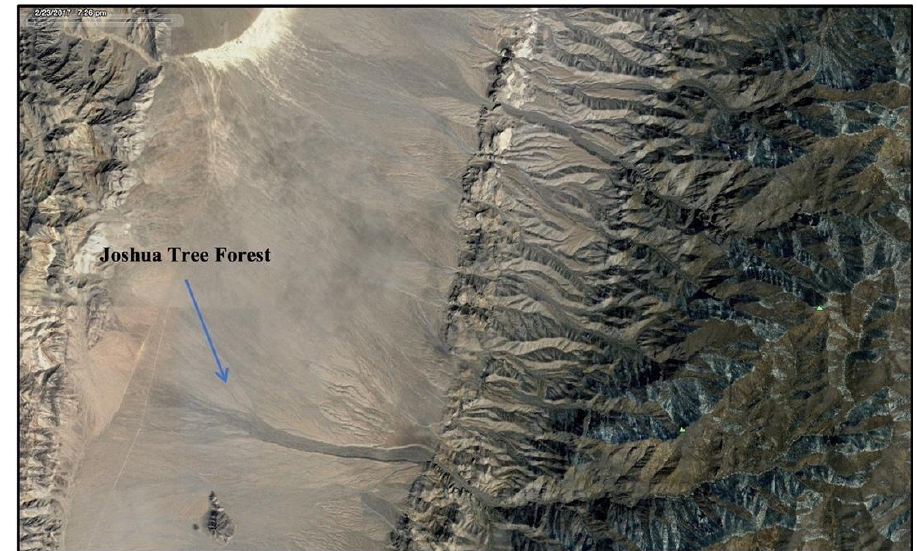
Figure 18. Location of Joshua Tree Forest (Source: Google Earth).